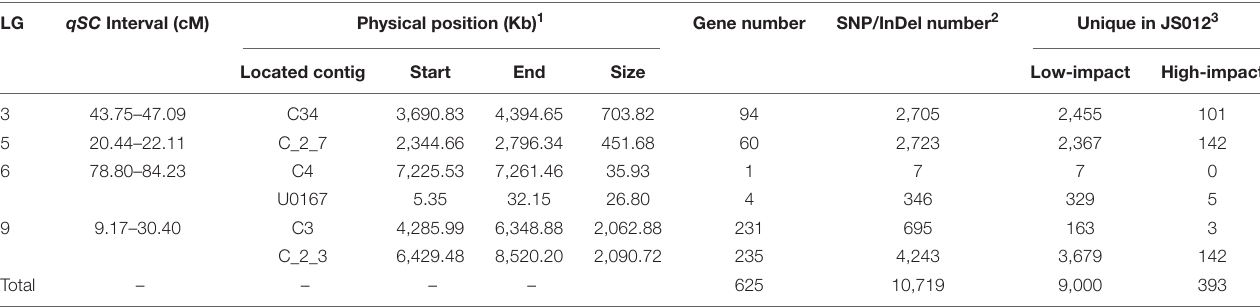
TABLE 3 | Genes and variants in the four merged qSC intervals based on the sesame genome